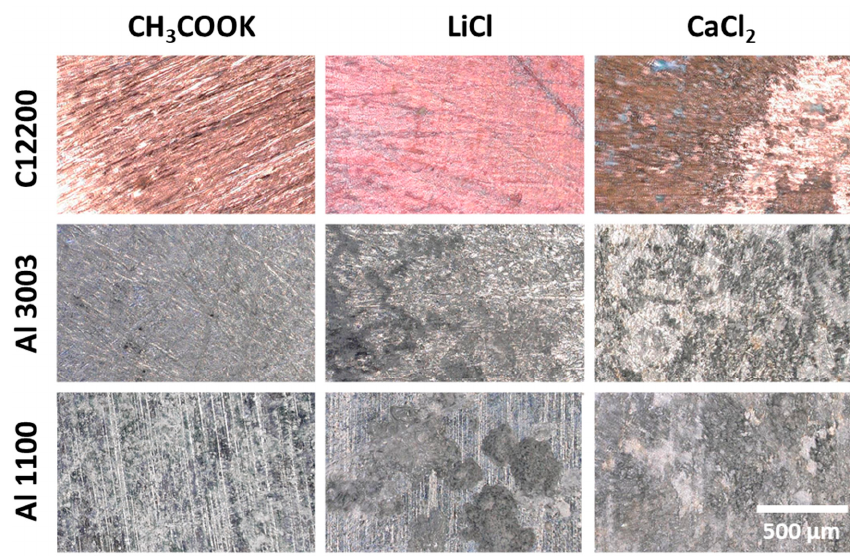
Figure 6. Images of WE surfaces after electrochemical corrosion experiments at 80 °C. Images were taken using an optical microscope.